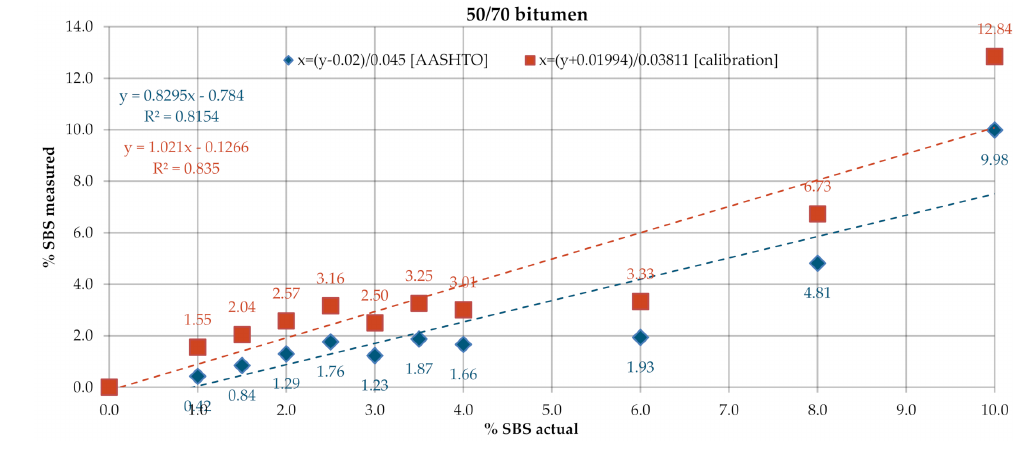
Figure 10. SBS contents in bitumen 50 / 70, ATR.